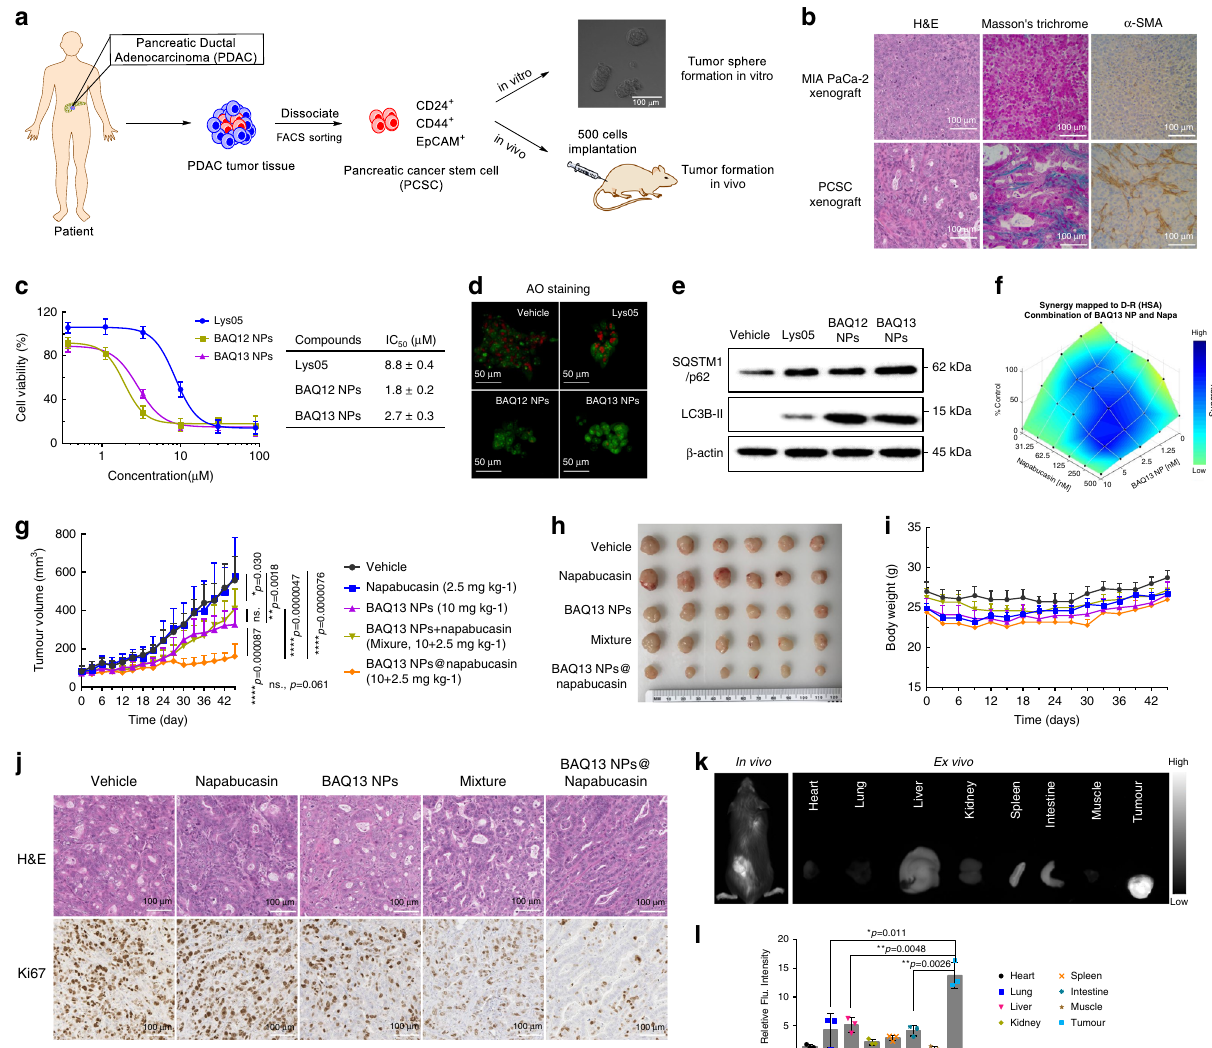
Fig. 6 BAQ ONNs have dual roles in the combination treatment. a Establishment of the patient-derived pancreatic cancer stem cell (PCSC) model. b Histological analysis showing the high-level stroma of PCSC tumours; experiments were repeated three times independently. c Viability curves of PCSCs that were treated for 48h and the IC 50 values; n = 3 independent experiments. d AO staining to show the LMP of PCSC that were treated for 12h; experiments were repeated three times independently. e Immunoblotting analysis of autophagy proteins in PCSC that were treated as indicated (2.5 µ M, 48h); experiments were repeated three times independently. f Synergistic effect of BAQ13 NPs and napabucasin (48h). g Tumour growth curves in subcutaneous PCSC xenograft model within the indicated treatments every 3 days; data are mean values±SD; n = 10 tumours per group. h Images of tumours that harvested at end of treatment. i Mice body weight changes during the treatment; data are mean values±SD; n = 5 mice per group. j Representative images of PCSC tumour sections; experiments were repeated three times independently. k In vivo and ex vivo fl uorescence imaging of BAQ13 NPs co-loading with napabucasin and DiD in the PCSC model at 48h post intravenous injection (10mgkg − 1 ). l Quantitative fl uorescence intensity of tissues in k , data are mean values±SD; n = 3 mice per group. All statistical p values were calculated by the two-tailed Student ’ s t test. ns not signi fi cant; * p <0.05; ** p <0.01; **** p